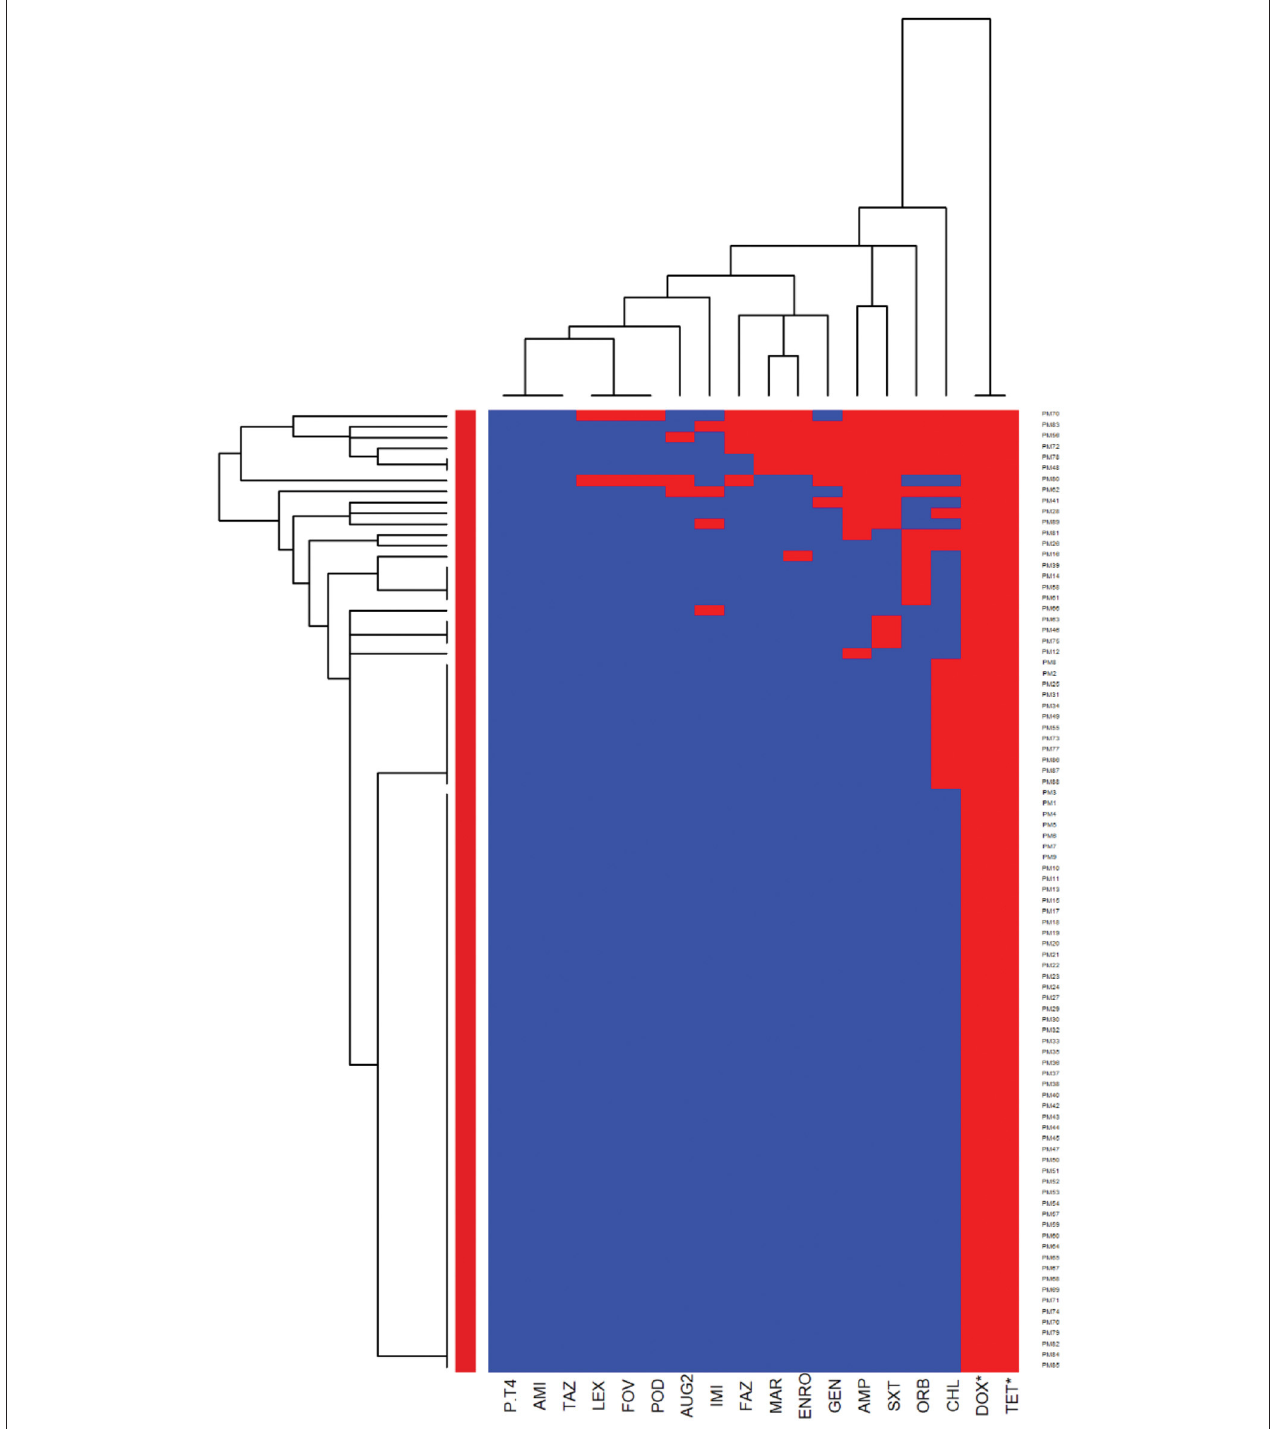
FIGURE 5 | Antimicrobial resistance clustering dendrogram of Proteus mirabilis isolated from canine urine samples a,b,c . a AMI, Amikacin; GEN, gentamicin; AUG2, amoxicillin-clavulanic acid; PT4, piperacillin-tazobactam; FAZ, cefazolin; FOV, cefovecin; POD, cefpodoxime; TAZ, ceftazidime; LEX, cephalexin; IMI, imipenem; SXT, trimethoprim-sulfamethoxazole; ENRO, enrofloxacin; MAR, marbofloxacin; ORB, orbifloxacin; AMP, ampicillin; CHL, chloramphenicol; DOX, doxycycline; TET, tetracycline. *Intrinsic resistance. b Heatmap generated by hierarchical clustering of the antimicrobial resistance determinants (columns) of bacterial isolates (rows). c Red color, resistant; blue color,